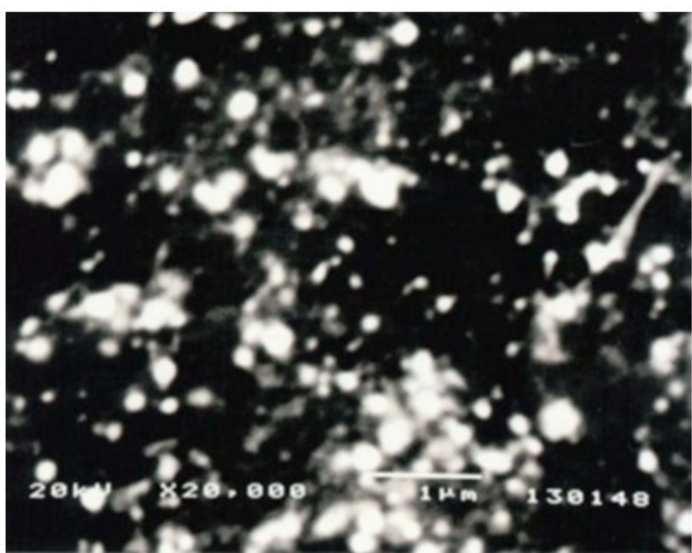
O particles (N). 3 4